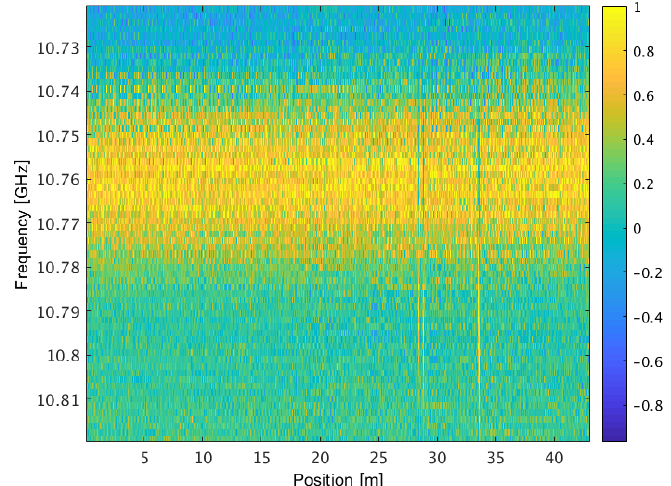
Figure 7. Double pulse-pair, phase-coded B-OCDA map of Brillouin gain as a function of position along a fiber under test and the frequency offset between the pump and signal waves [23]. A 43-m-long fiber was monitored with 2.7 cm resolution. All 1600 resolution points were addressed in only 11 scans of correlation peak positions [23]. Three 8-cm-wide heated regions are well identified in the measurements. Reproduced with permission from [23], Optical Society of America, 2016.